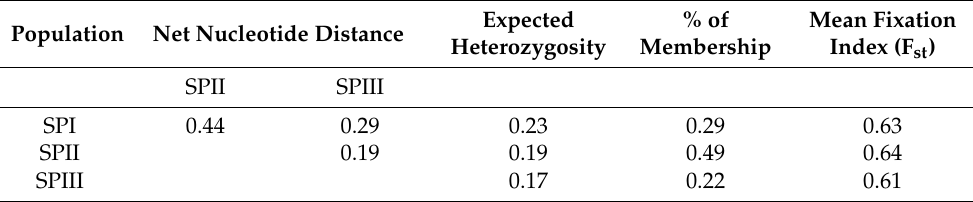
Table 2. Genetic divergence among (net nucleotide distance) and within accessions from population structure.